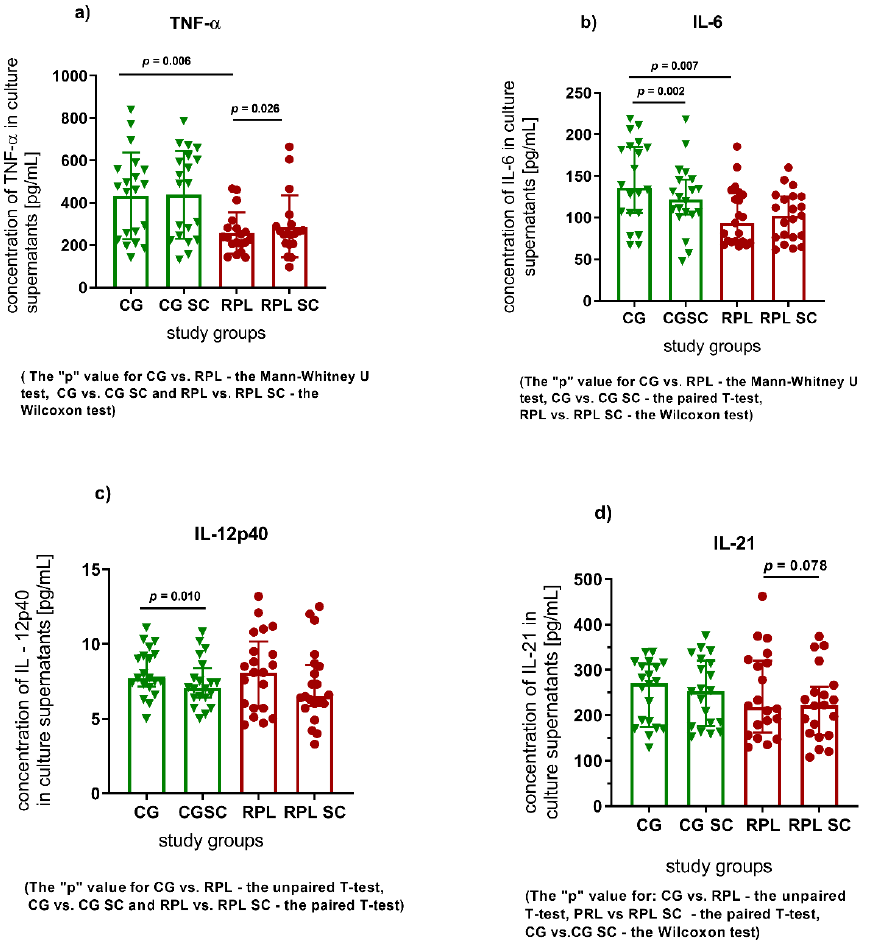
Figure 1. Changes in the concentration of pro-inflammatory cytokines in the culture supernatants of the PBMC cells of fertile and RPL women supplemented with 400 ng/mL sildenafil citrate, ( a ) TNF – α concentration in culture supernatants, ( b ) IL-6 concentration in culture supernatants, ( c ) IL-12p40 concentration in culture supernatants, ( d ) IL-21 concentration in culture supernatants, (CG—control group, green symbols, n = 20; RPL—study group, red dots; n = 21; SC—sildenafil citrate; data shown as individual values, the median and IQR). The tests used to establish significant differences are given below graphs.